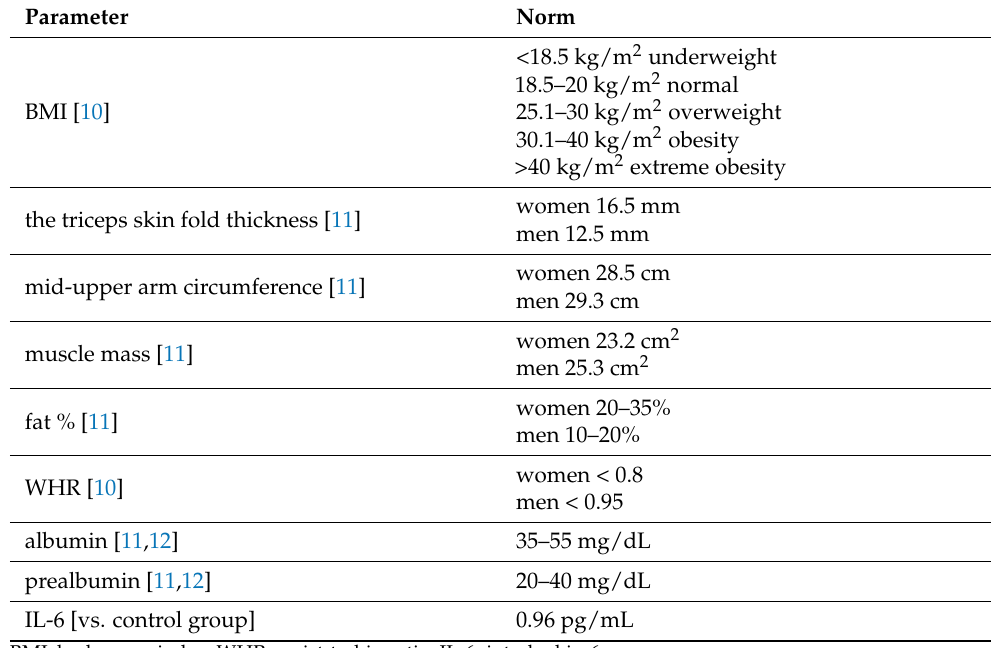
Table 1. Anthropometric measurement